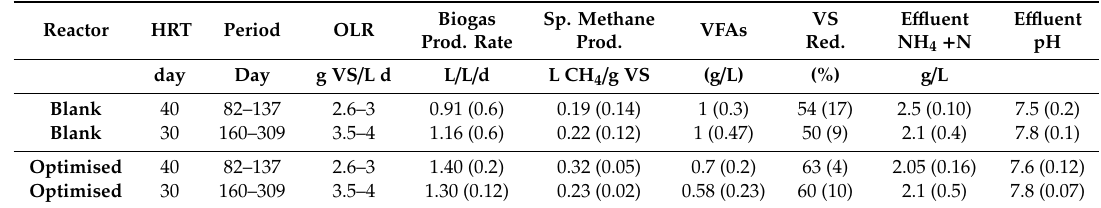
Table 2. Average operating conditions, gas production and e ffl uent values of the optimised and blank CDD reactor under ‘steady state’ conditions in the optimised